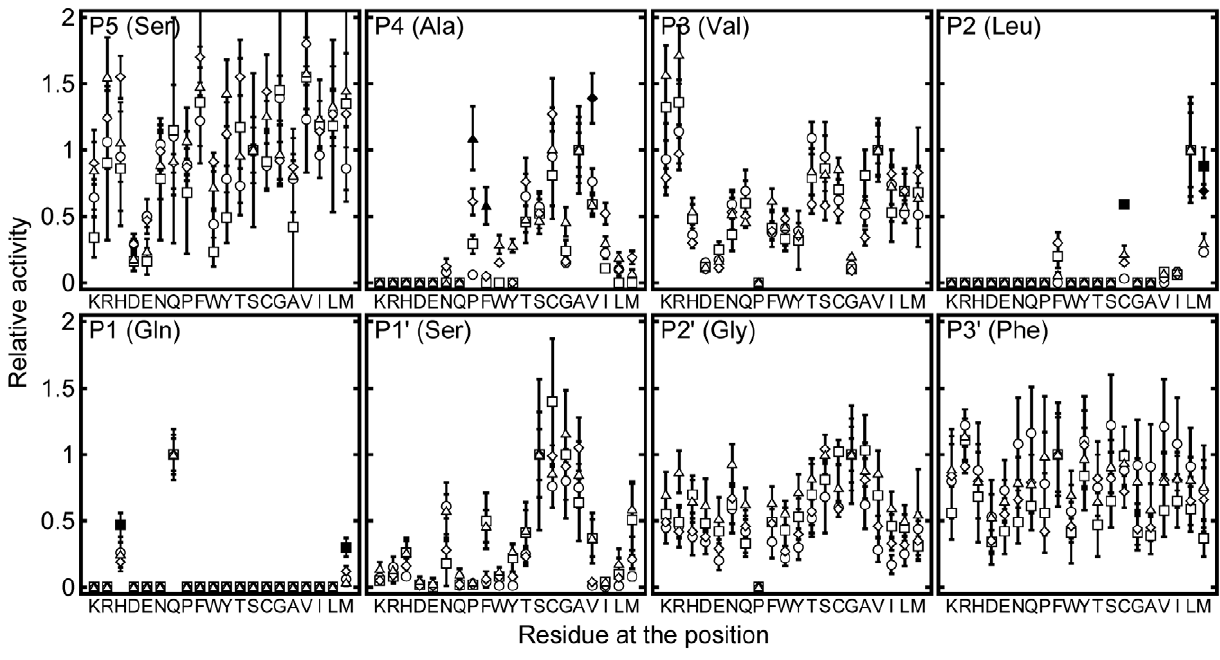
Figure 1. Substrate specificity of 3CL pro at P5 to P3’ positions. Relative protease activity of 3CL pro from HCoV-NL63 (circles, group 1), HCoV- OC43 (squares, group 2a), SARS-CoV (diamond, group 2b) and IBV (triples, group 3) against 19 6 8 of substrate variants were measured by FRET assay. Relative activities that are significantly (p-value , 0.001) higher than the rest are represented as filled symbols.